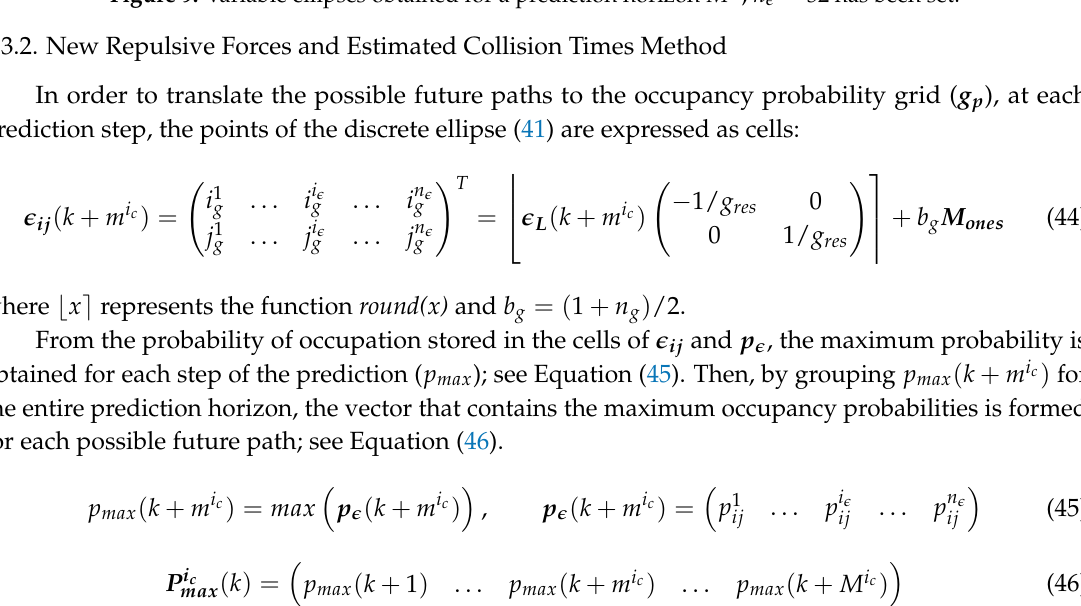
Figure 9. Variable ellipses obtained for a prediction horizon M i c ; n (cid:101) = 32 has been